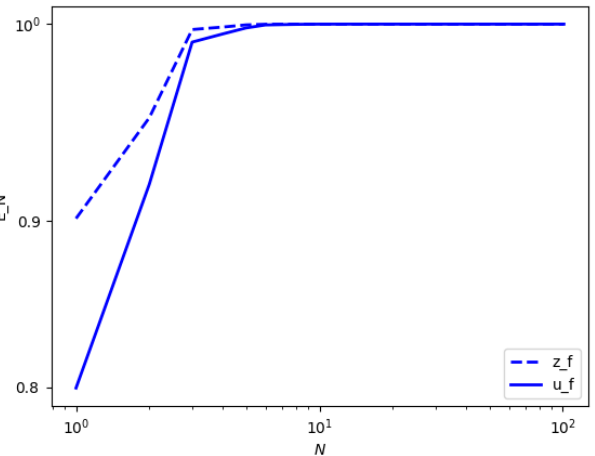
Figure 24. A comparison between the energy retained by the first modes for z f and for u f